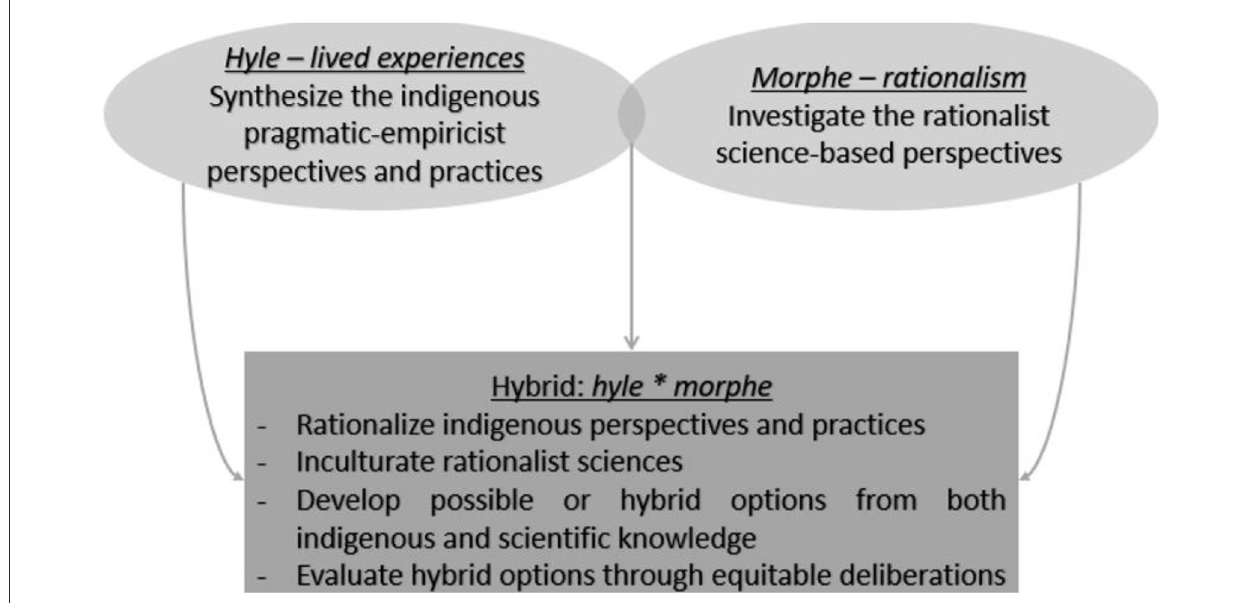
FIGURE1 Graphical summary of the hylomorphic framework—Adapted from Bwambale and Kervyn